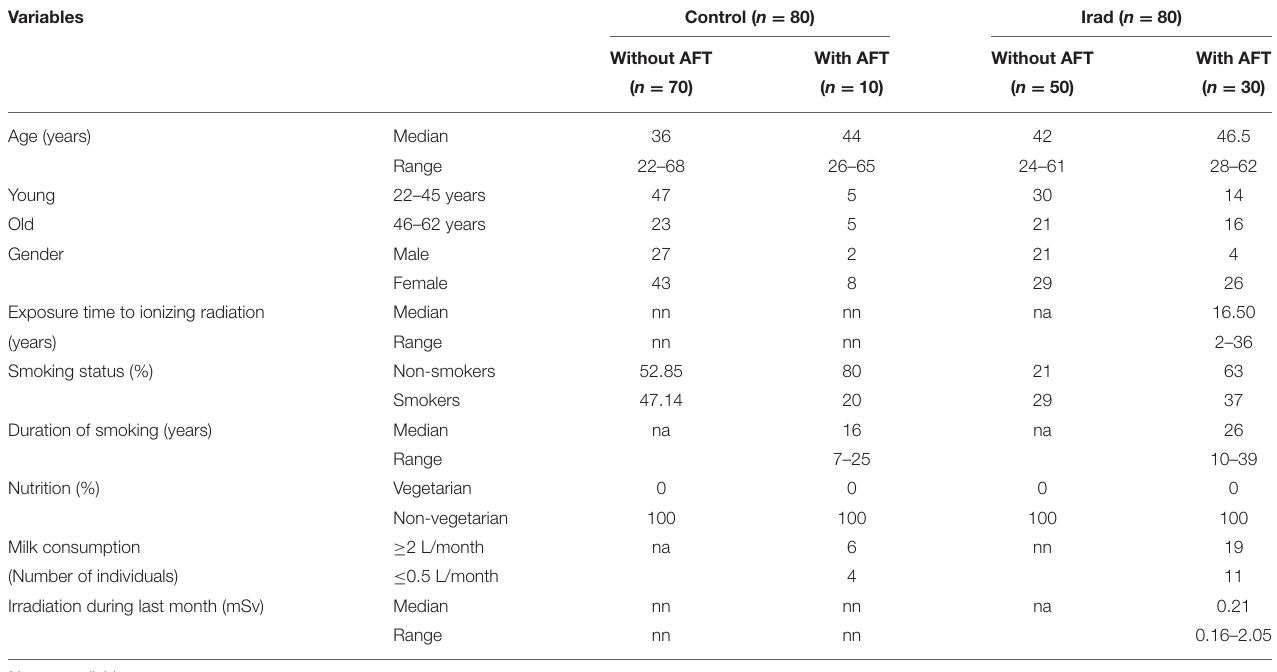
TABLE 1 | Characteristics of subjects included in the study.